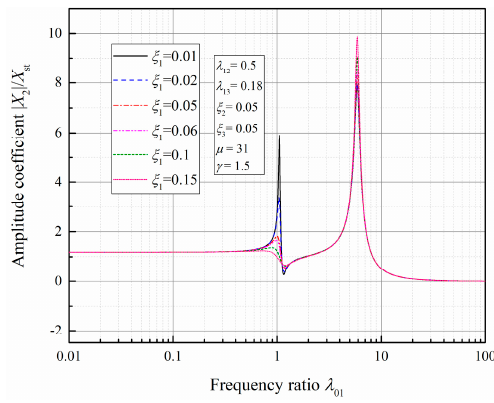
Appl. Sci. 2019 , 9 , x FOR PEER REVIEW Figure 13. The dynamic response of the accessory structure upon varying the parameter